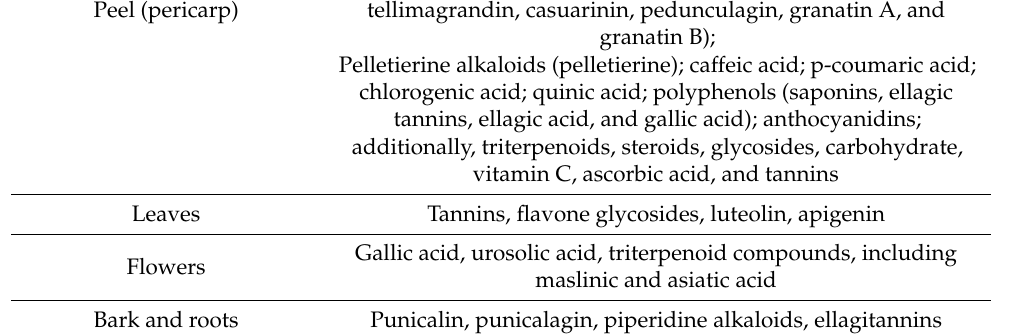
Table 2. Pomegranate plant parts and their chemical constituents.